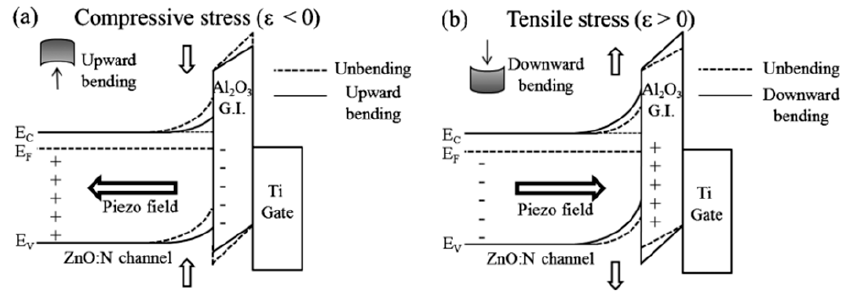
Figure 15. Electrical transport behaviors under two kinds of strains; ( a ) compressive stain and ( b ) tensile stain in flexible TFTs [81].